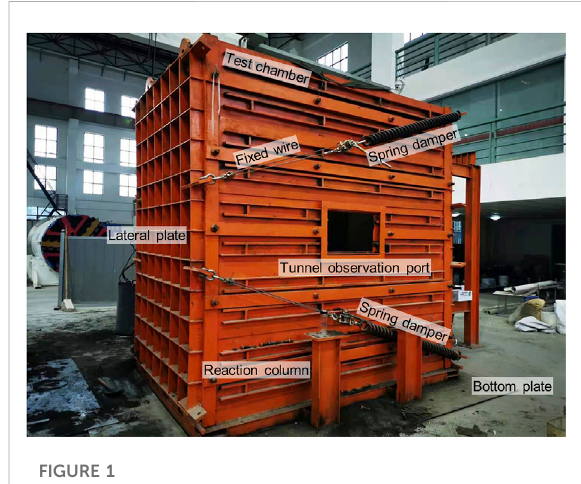
FIGURE 1 Dynamic-static coupling model